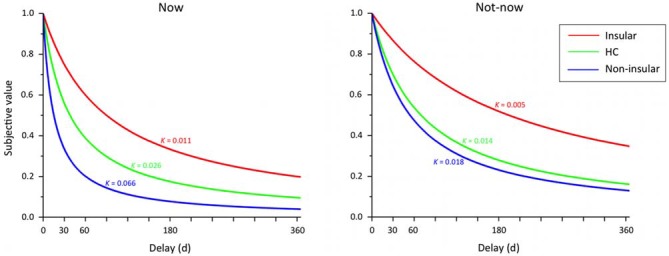
Temporal discounting (TD) functions by participant group (Insular = patients with lesions in the insular cortex; Non-insular = patients with lesions outside the insular cortex; HC = healthy controls) and type of temporal condition. The hyperbolic curves describe the discounting of subjective value (expressed as a proportion of the delayed amount) as a function of time (days). The discounting parameter k reflects the geometric mean of the group.